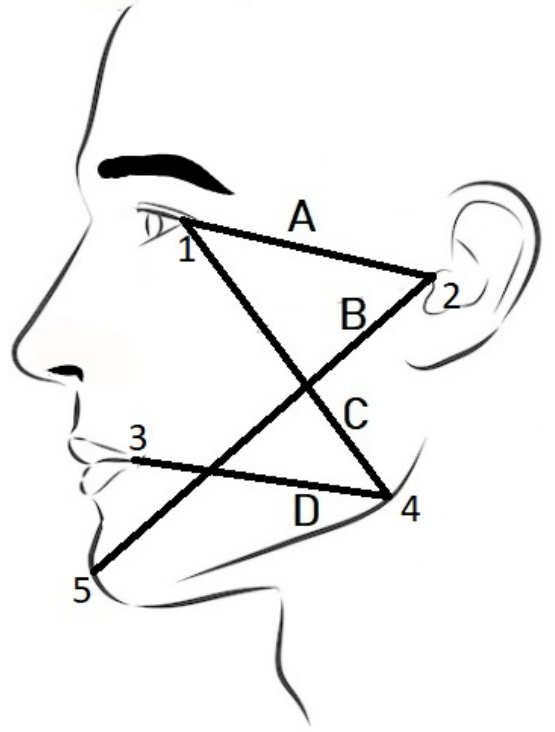
Figure 2. Demarcation lines used for the assessment of the post-surgery oedema; 1— the lateral cantuhus of the eye , 2— tragus , 3— labial commissure , 4— gonion , 5— pogonion